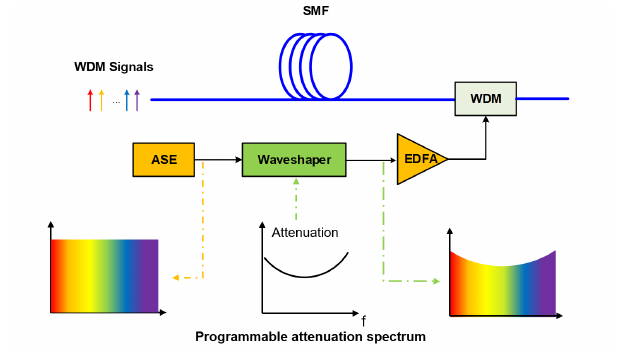
Figure 2. The configuration of DRA with broadband